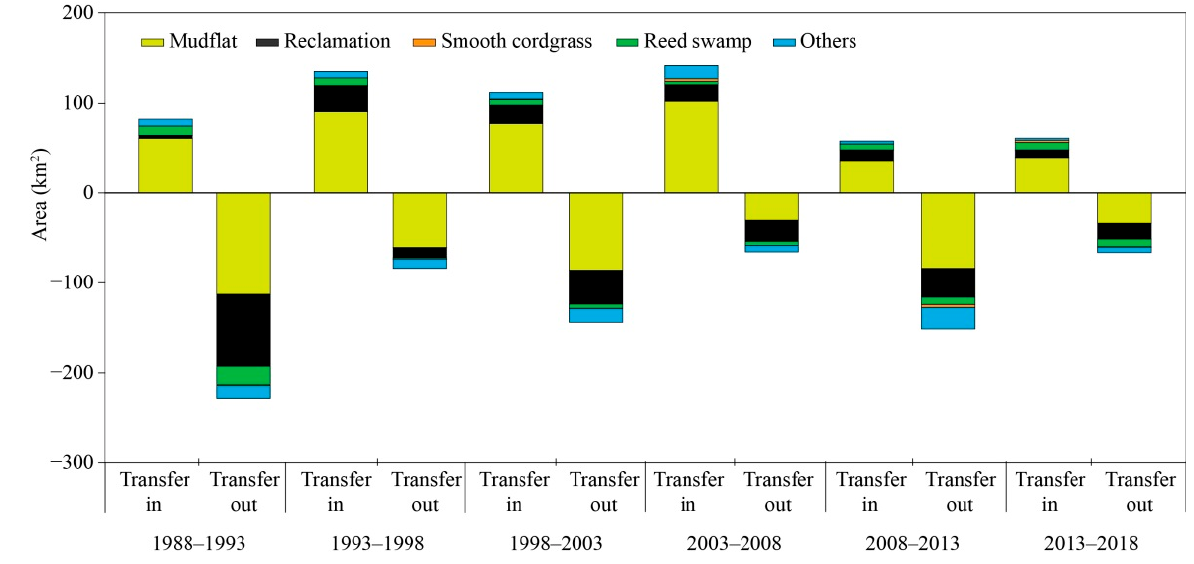
Figure 7. Land change between S. salsa saltmarsh area and other habitats near the NYSC from 1988 to 2018.